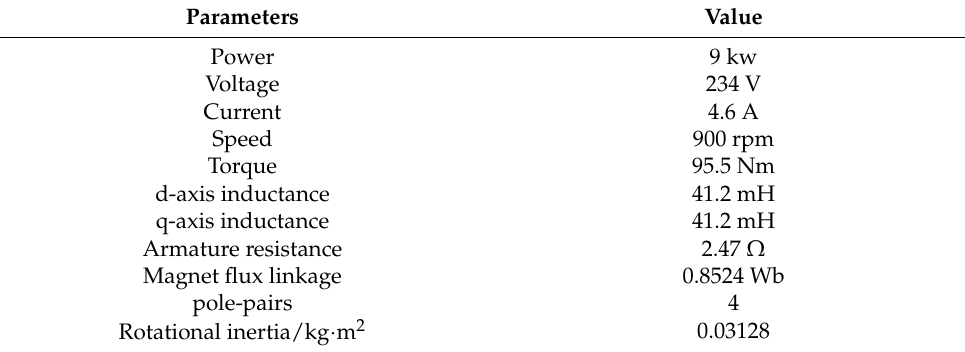
Table 1. Nine-phase PMSM